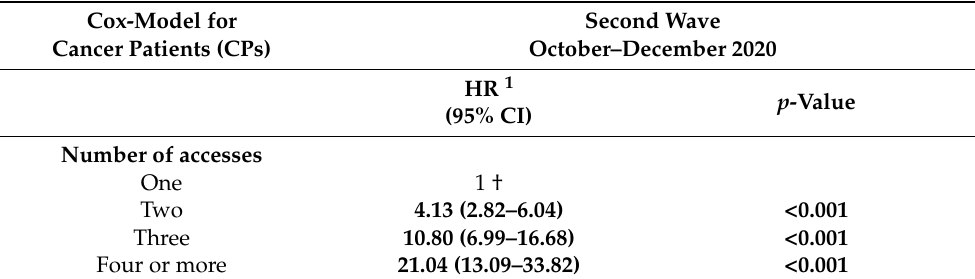
Table 6. Cox-model for CPs in the second pandemic wave.